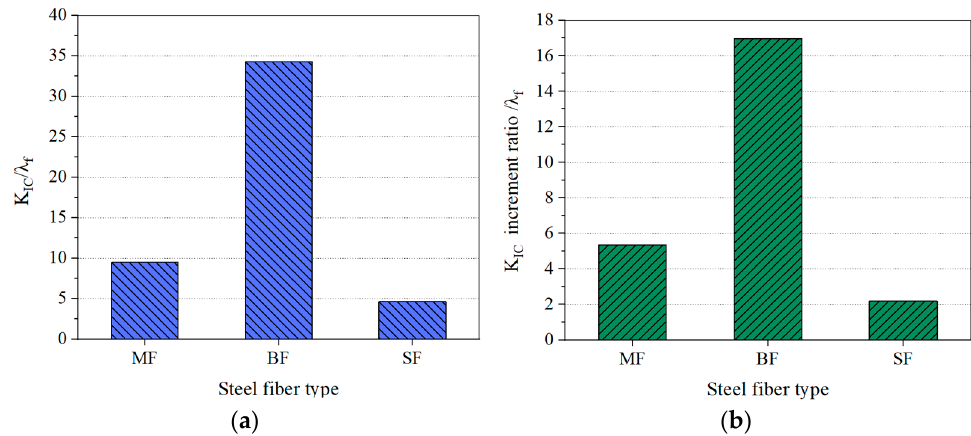
Figure 9. Influence of steel fiber types on the K IC ( a ) and K IC increment ratio ( b ) of SFHSC.